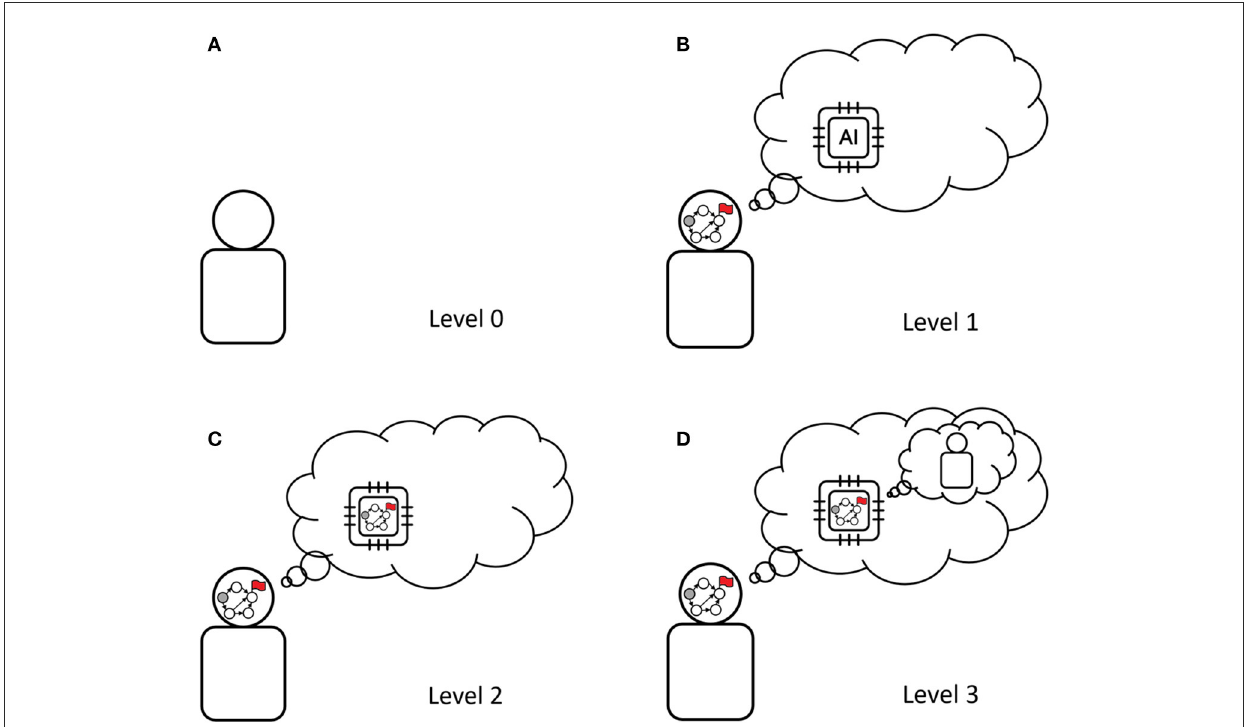
FIGURE2 Four levels of user models. Each level corresponds to the AI assuming a different mode of decision-making of the user. An AI system having a higher-level user model is able to take into account different types of user’s reasoning. The graph in the head of some users and in the AI’s chip denotes planning capability: it is a planning graph with the red flag signifying a goal. The AI having access to a higher-level user model means that the AI has more advanced user modeling capabilities, accounting for the user reasoning about the AI. From left top to right bottom: (A) Level 0 : the user is not pursuing a goal, (B) Level 1 : the user is pursuing a goal, but does not consider the AI is pursuing one as well, (C) Level 2 : the user is pursuing a goal and understands that the AI is pursuing a goal too, (D) Level 3 : the user is pursuing a goal, understands that the assistant is doing the same, and that the assistant will interpret user actions as